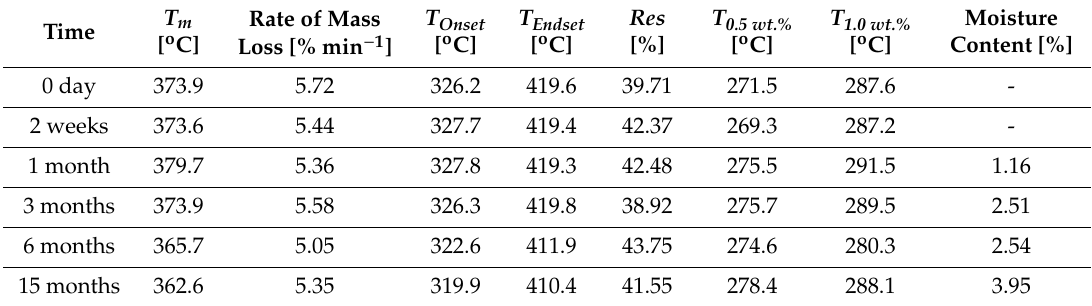
Table 4. The thermal decomposition parameters of amorphous imatinib mesylate (IM).